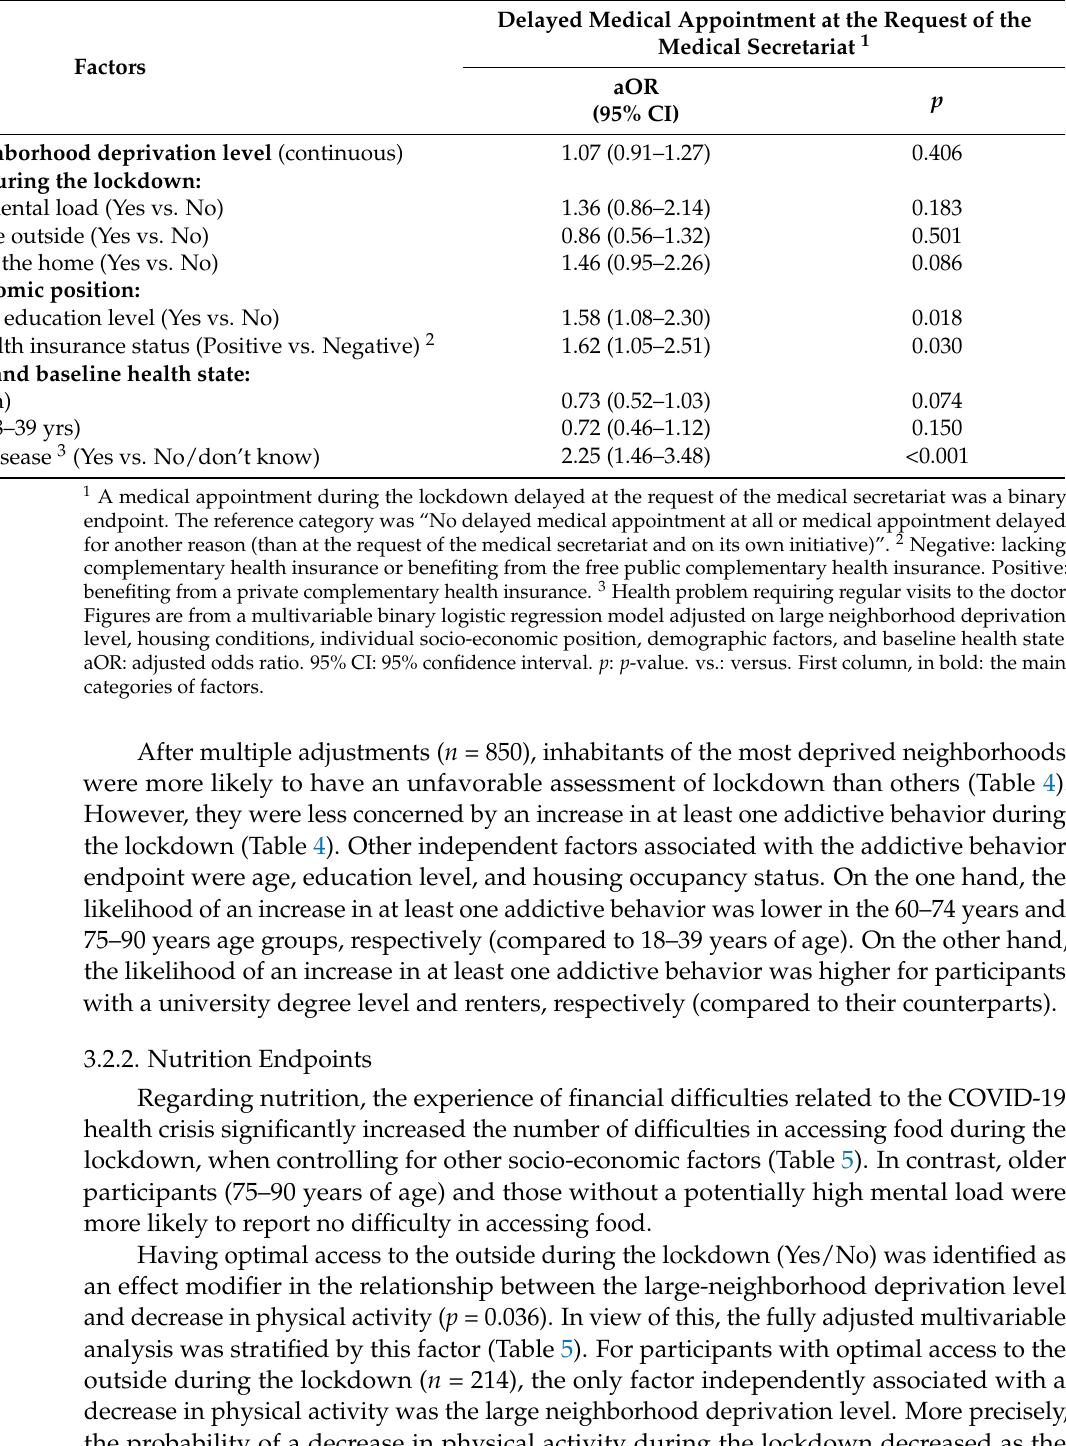
Table 6. Factors independently associated with health care use endpoint in the adult population during the COVID-19 lockdown (R é -Conf-ISS cross-sectional study: Reunion Island, 13 May and 22 July 2020)—fully adjusted multivariable model